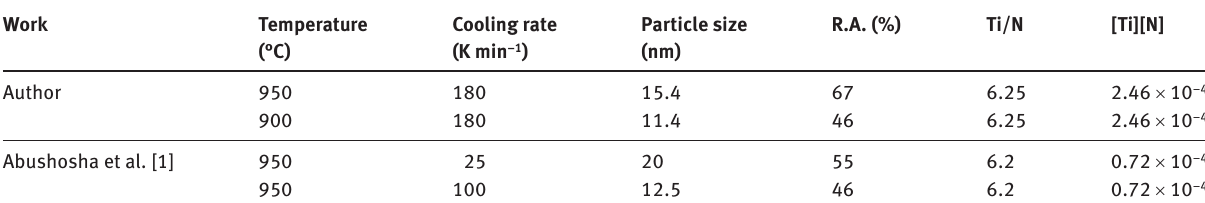
Table 2: Contrast information of TEM replica micrographs Work